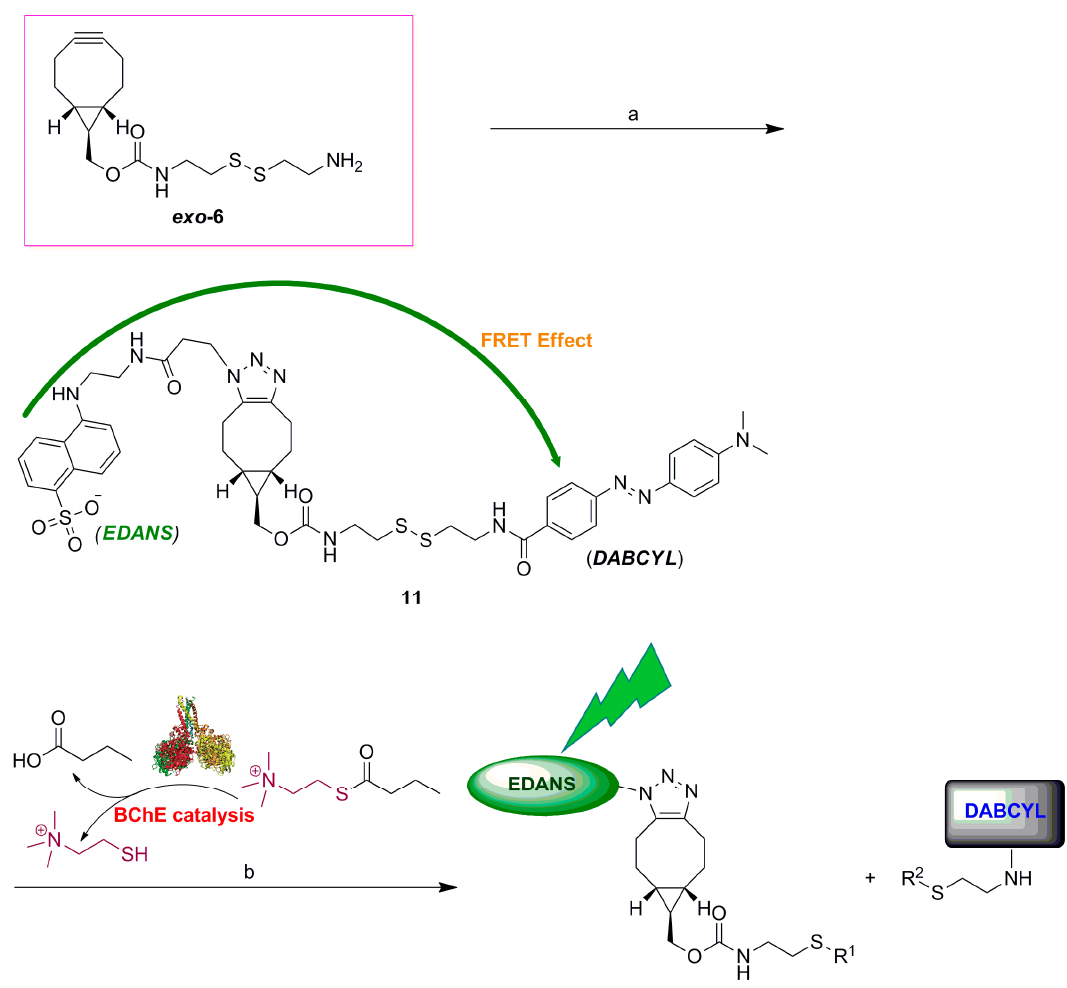
Scheme 1. Synthesis of the FRET chemical probe 11 from exo -6 and the use of 11 to quantitatively analyze inhibition and activity of BChE. ( a ) 10 , N -succinimidyl 4-[4- analyze inhibition and activity of BChE. ( a ) 10 , N -succinimidyl 4-[4-(dimethylamino)phenylazo]benzoate (dimethylamino)phenylazo]benzoate (DABCYL NHS ester), N , N -diisopropylethylamine (DIPEA), (DABCYLNHSester), N , N -diisopropylethylamine(DIPEA),dimethylformamide(DMF),roomtemperature dimethylformamide (DMF), room temperature (rt); ( b ) phosphate buffer (PB), 37 °C. Thiocholine (rt); ( b ) phosphate buffer (PB), 37 ◦ C. Thiocholine (TCh) was one of the products of BChE catalysis and is (TCh) was one of the products of BChE catalysis and is highlighted in pink. The thiolate of TCh later highlighted in pink. The thiolate of TCh later participated in nucleophilic attack on the disulfide bond in 11 participated in nucleophilic attack on the disulfide bond in 11 to obliterate the FRET effect and to to obliterate the FRET effect and to liberate the EDANS fluorescence. R 1 and R 2 , H, or the thiolate of liberate the EDANS fluorescence. R 1 and R 2 , H, or the thiolate of TCh.